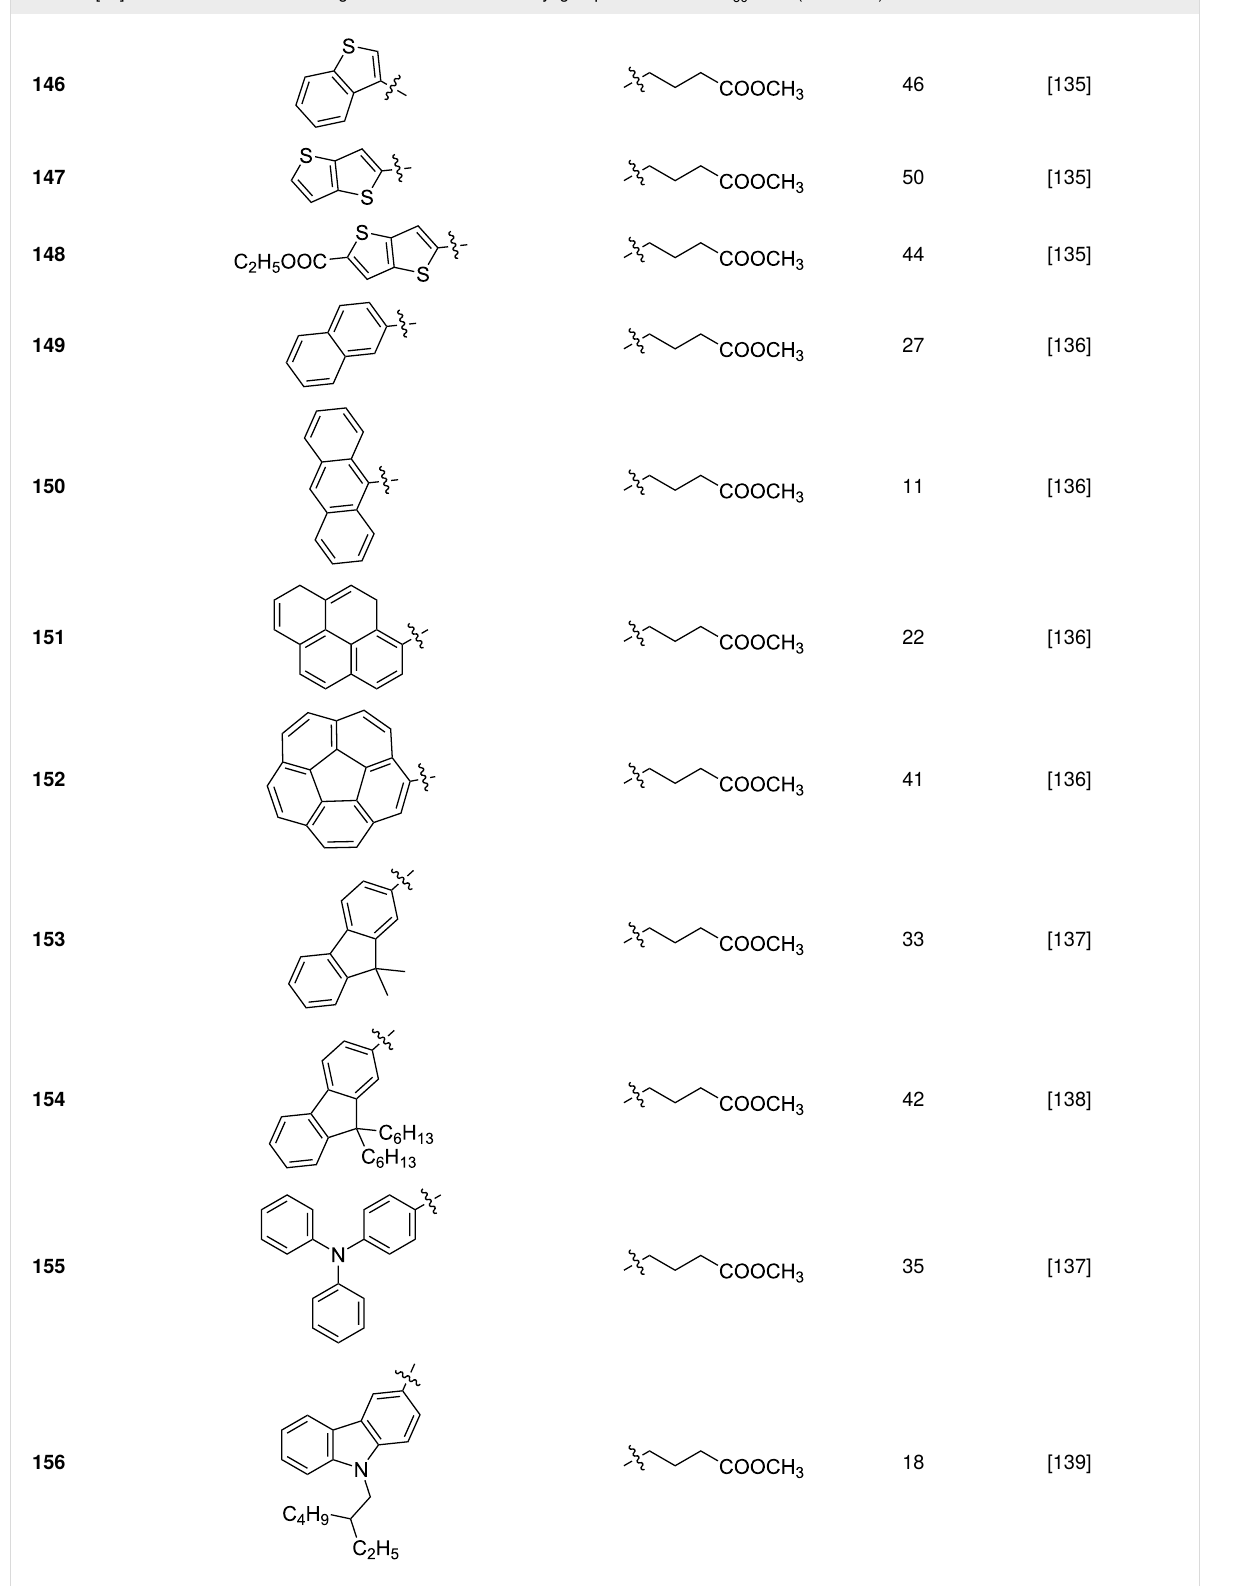
Table 1: [60]PCBM derivatives containing various aromatic and alkyl groups bound to the C 60 core.